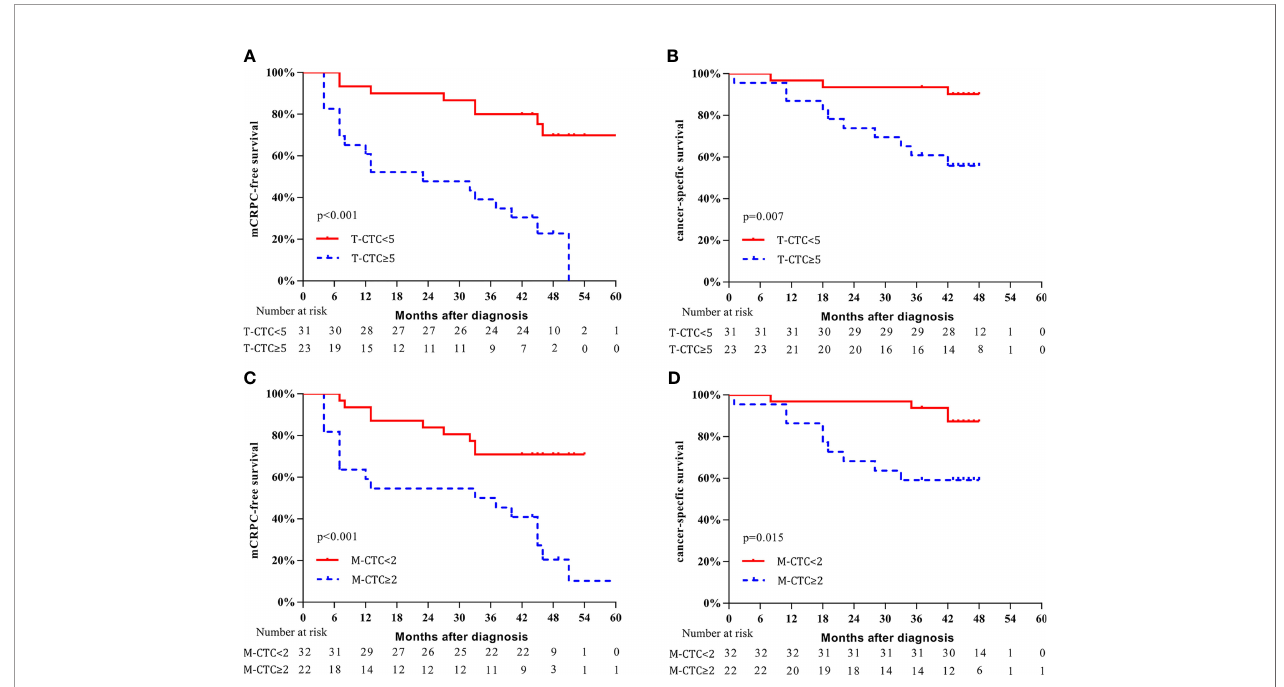
FIGURE 4 | Kaplan – Meier curves of survival outcomes according to CTC phenotype. (A) mCRPC-free survival strati fi ed according to T-CTC count. (B) CSS strati fi ed according to T-CTC count. (C) mCRPC-free survival strati fi ed according to M-CTC count. (D) CSS strati fi ed according to M-CTC